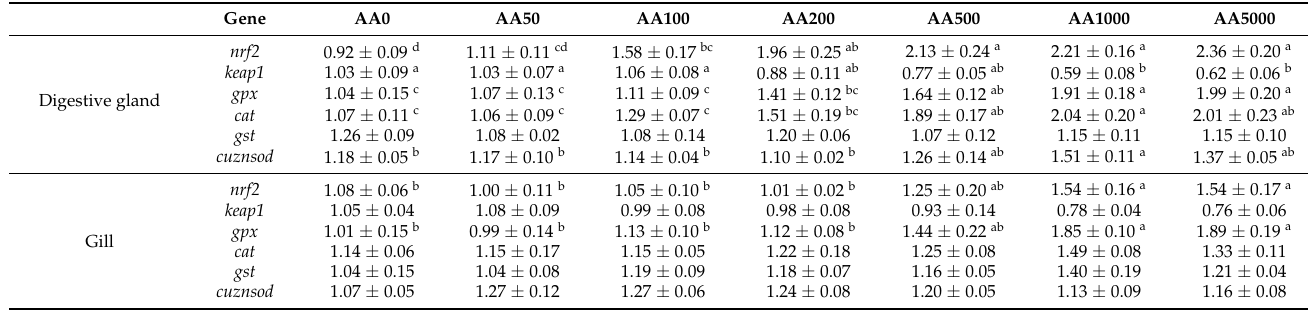
All data are expressed as mean ± SE (n = 3). nrf2: nf-e2-related factor-2 ; keap1: kelch-like ech-associating protein 1 ; gpx: glutathione peroxidase ; cat : catalase ; gst : glutathione-s-transferase ; cuznsod : copper-zinc-superoxide dismutase . The different lowercase letters in each row indicate significant differences ( p < 0.05).